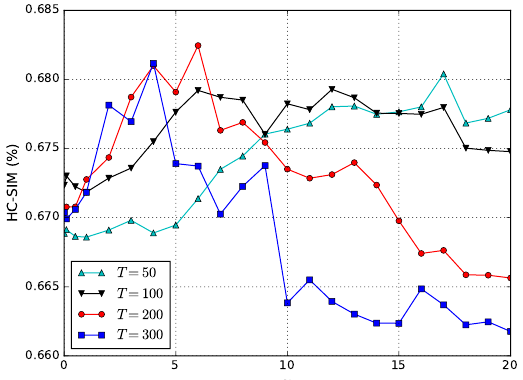
Figure 6. HC-SIM (in %) of the iTEKA centroid estimate relative to the ground truth trajectory when ν varies for T = 50, T = 100, 200 and